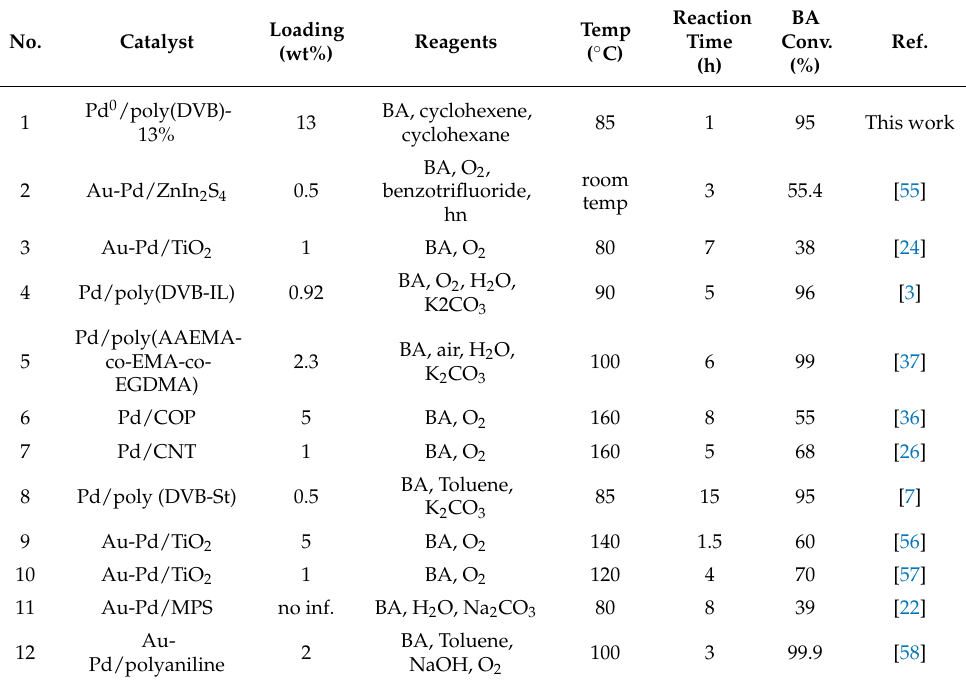
Table 4. Comparison of catalytic activities of Pd catalysts for the oxidation of benzyl alcohol (BA) a .